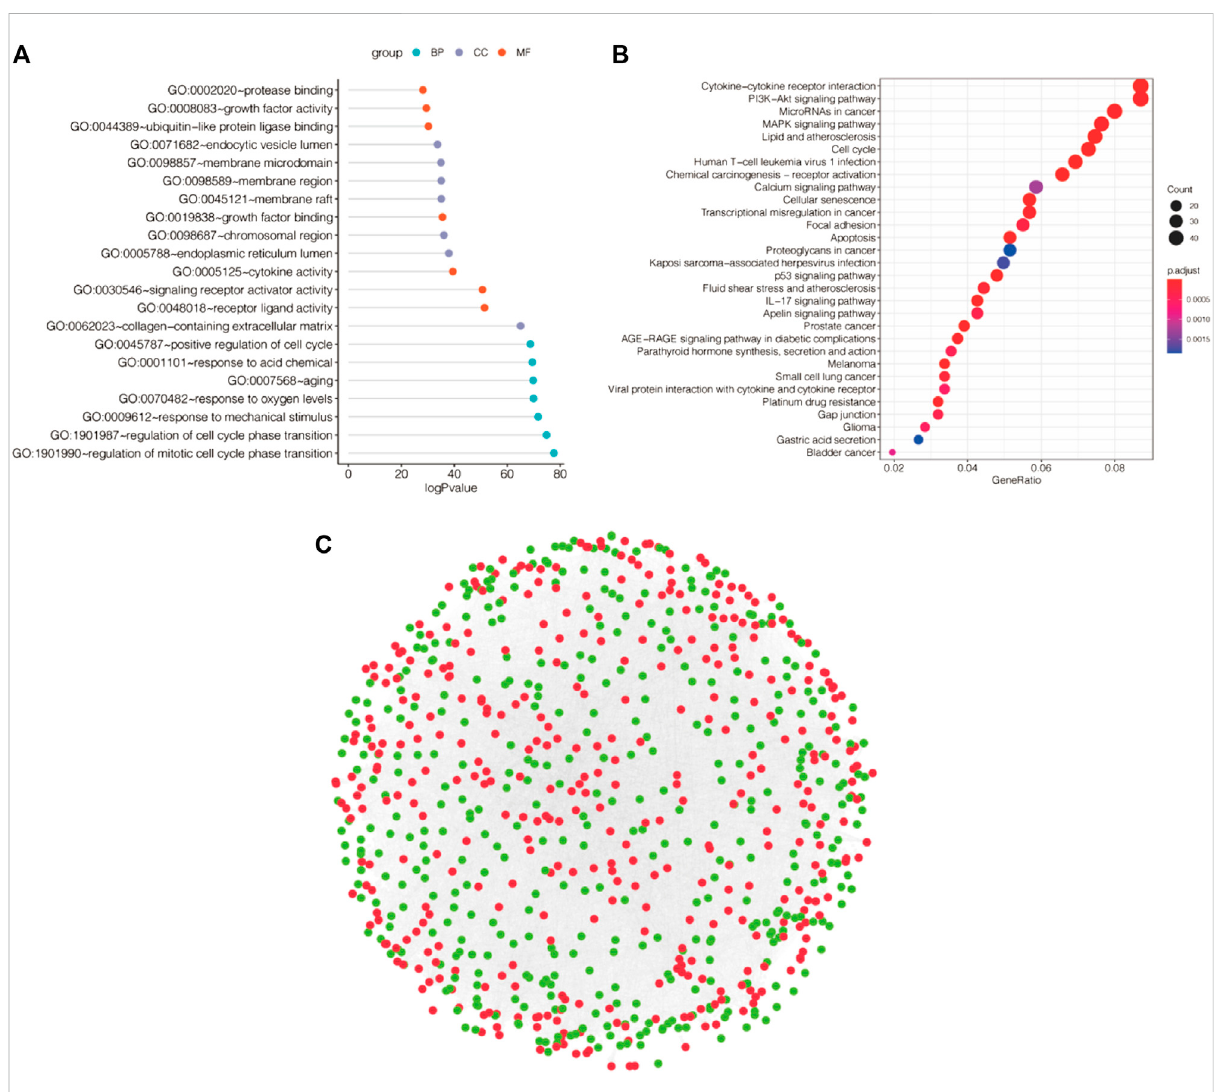
FIGURE 3 Functional enrichment analysis and PPI networks for differentially expressed genes. (A) GO enrichment analysis of differentially expressed apoptoticgenes. (B) KEGGenrichmentanalysisofdifferentiallyexpressedgenes. (C) PPInetwork.(Upregulatedgenesinred,downregulatedgenesin